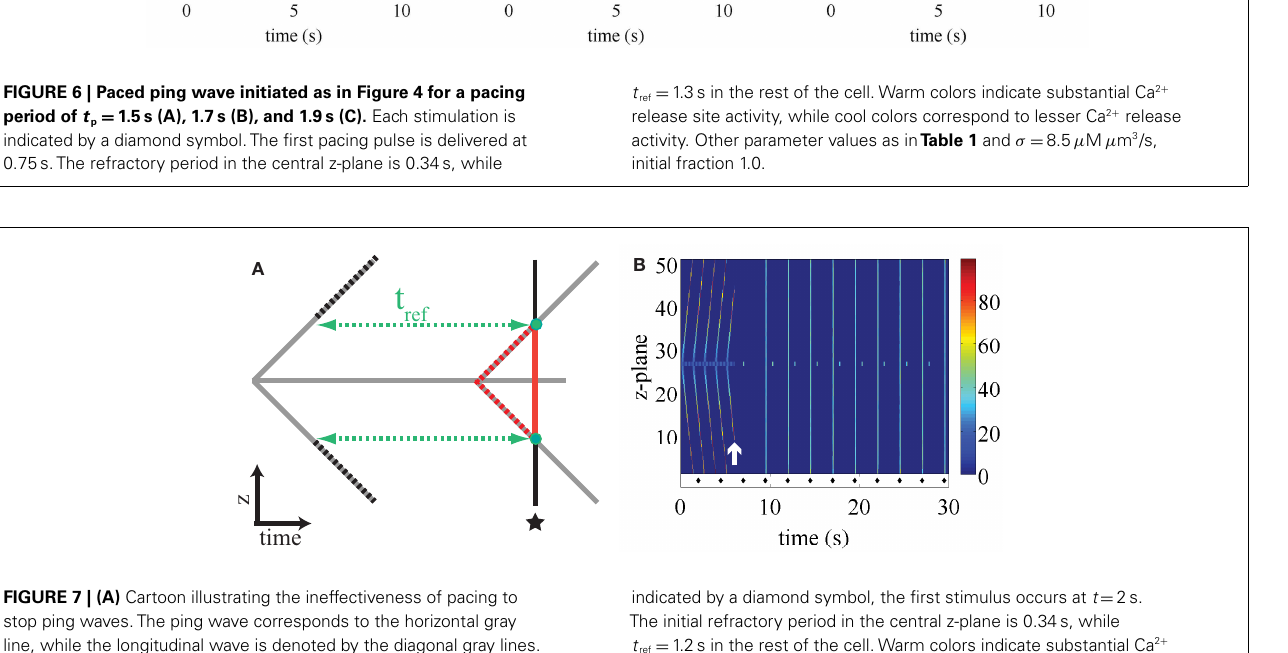
indicated by a diamond symbol, the first stimulus occurs at t = 2s. The initial refractory period in the central z-plane is 0.34s, while t ref = 1.2s in the rest of the cell.Warm colors indicate substantial Ca 2 + release site activity, while cool colors correspond to lesser Ca 2